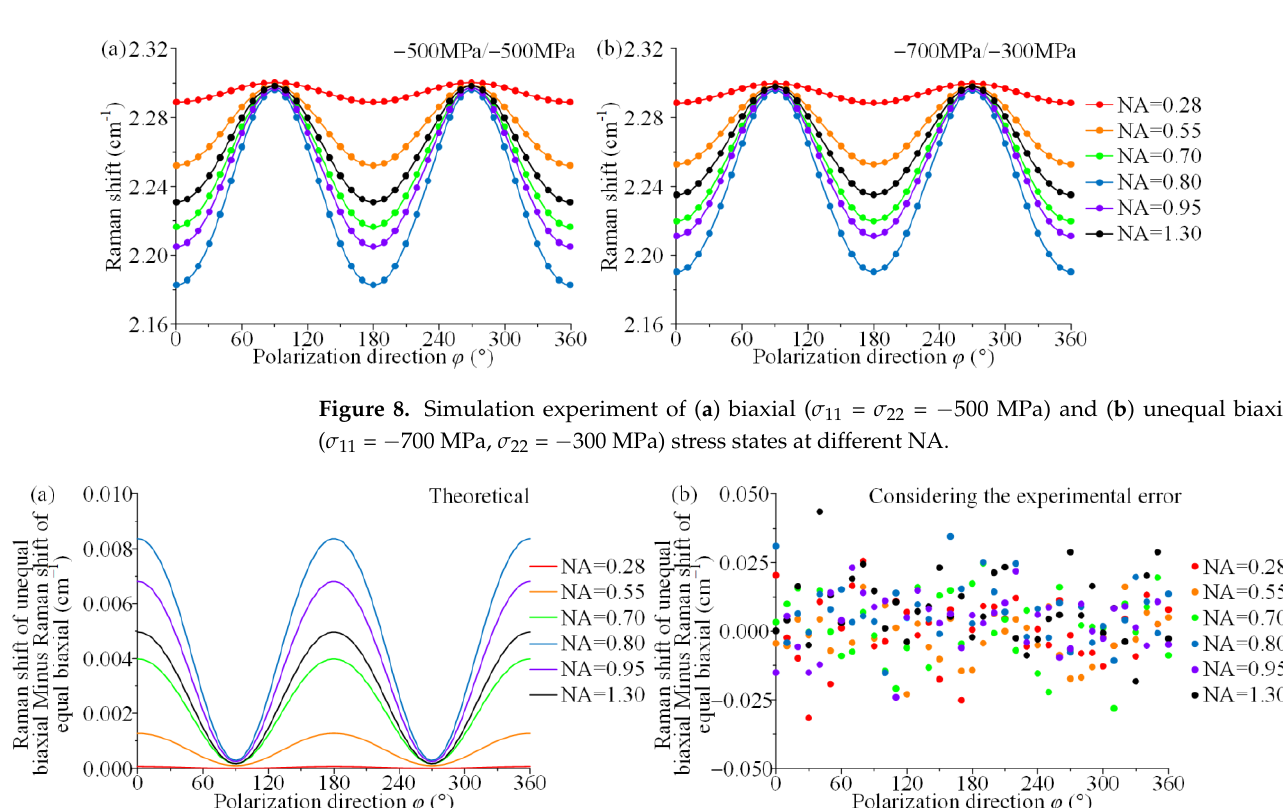
10 of 13 Figure 8. Simulation experiment of ( a ) biaxial ( σ 11 = σ 22 = −500 MPa) and ( b ) unequal biaxial ( σ 11 = −700 MPa, σ 22 = −300 MPa) stress states at different NA. The difference of the respective Raman shifts was taken at six different NAs, i.e., the curve of Figure 8b was subtracted from the curve of Figure 8a for identical NAs, and the